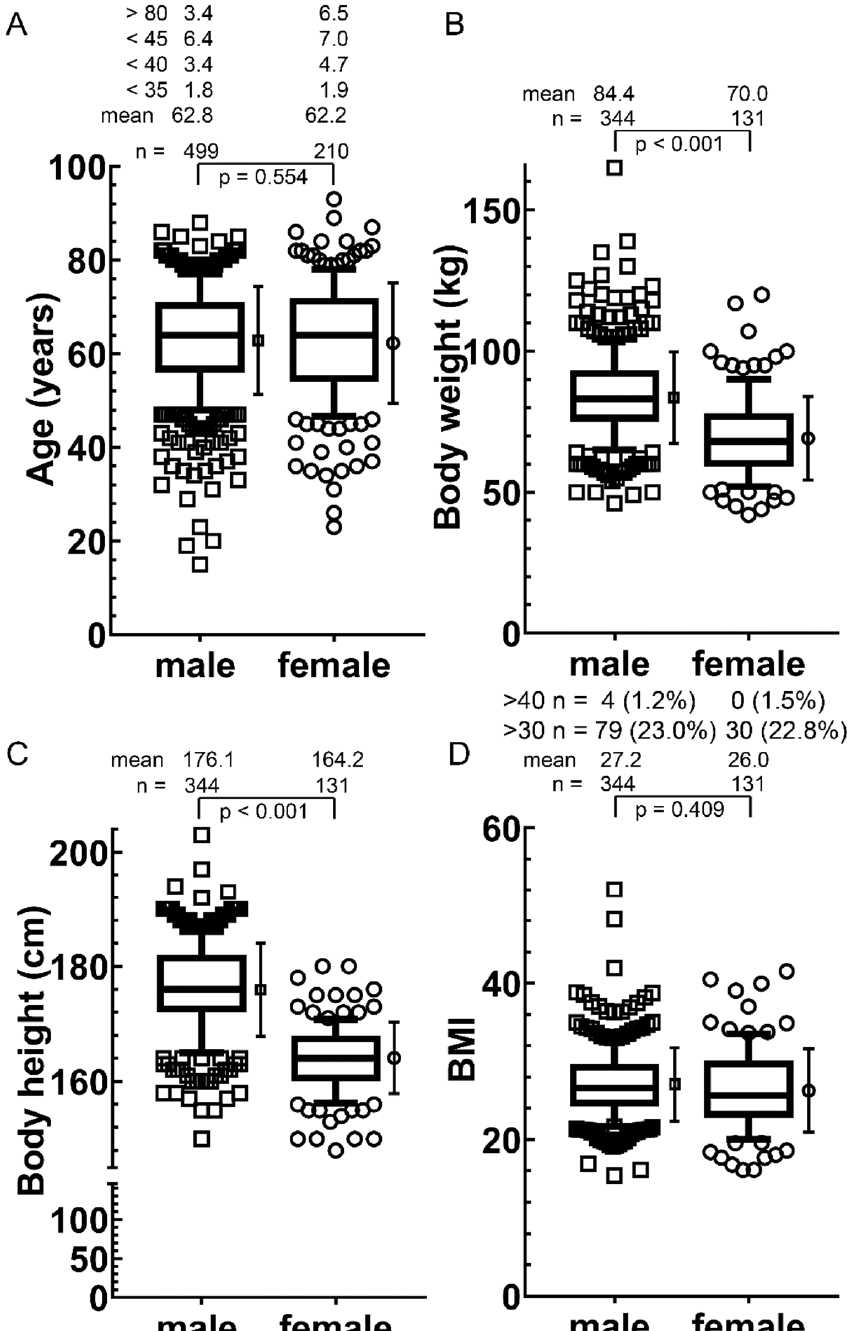
Figure 2. Age, body weight, height and body mass index compared between women and men in the entire cohort. Indicated are the number of individuals: ( A ) Age; ( B ) Body weight; ( C ) Height and ( D ) Body mass index. The box represents the median, the 25th to 75th percentiles and the whiskers of the 10th to 90th percentiles. The mean and standard deviation are shown to the right of the box; p -values were calculated by the Student’s t -test.